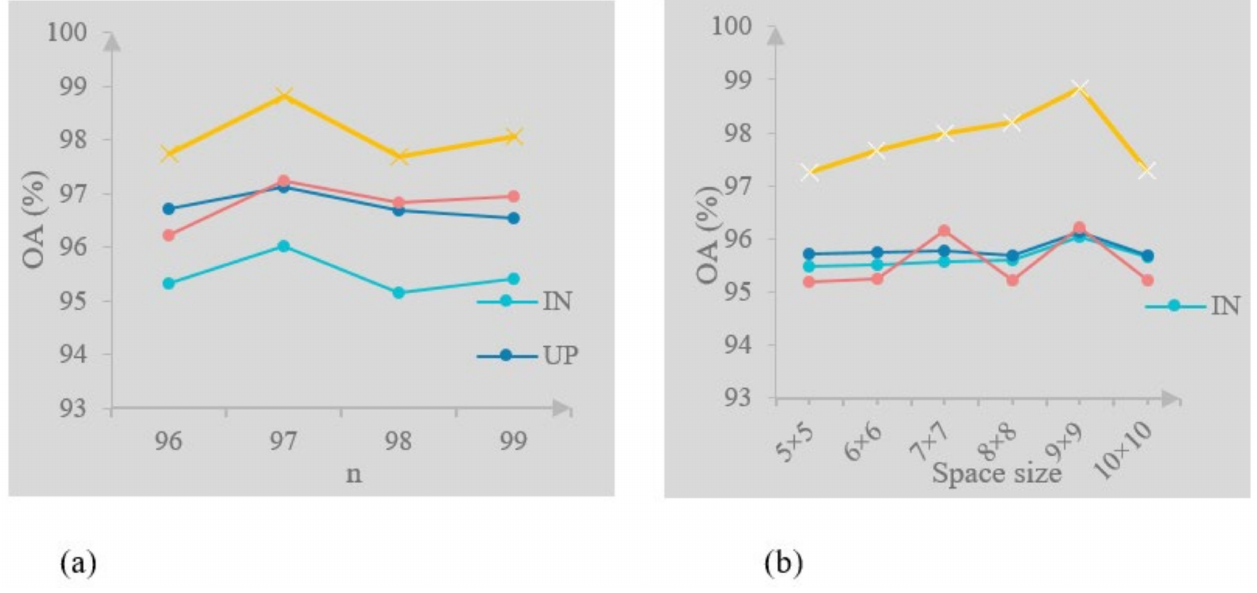
Figure 6. ( a ) The OA effect of n on the four hyperspectral image data sets. ( b ) The OA effect of spatial size on the four hyperspectral image data